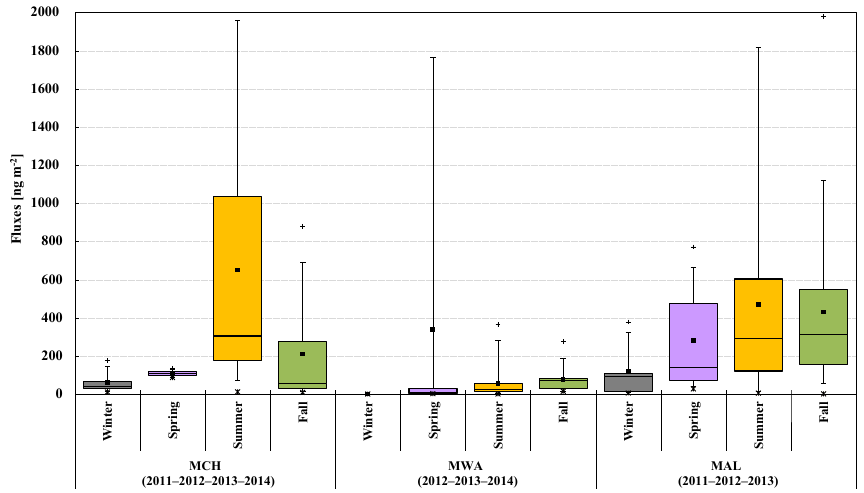
Figure 7. Seasonal distribution of sampling-weighted (by 15-day reference) fluxes at the three Chinese GMOS sites from 2011 to 2014. Each box includes the median (midline), mean ( (cid:4) ), 25th and 75th percentiles (box edges), 5th and 95th percentiles (whiskers), minimum ( ∗ ), and maximum ( +